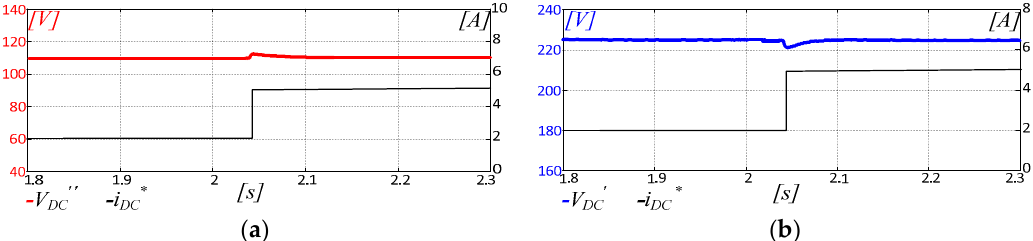
Figure 20. Averaged-value model. Load variation i DC* . ( a ) TLI DC bus voltage V DC ʹʹ . ( b ) Output voltage V DC ' .